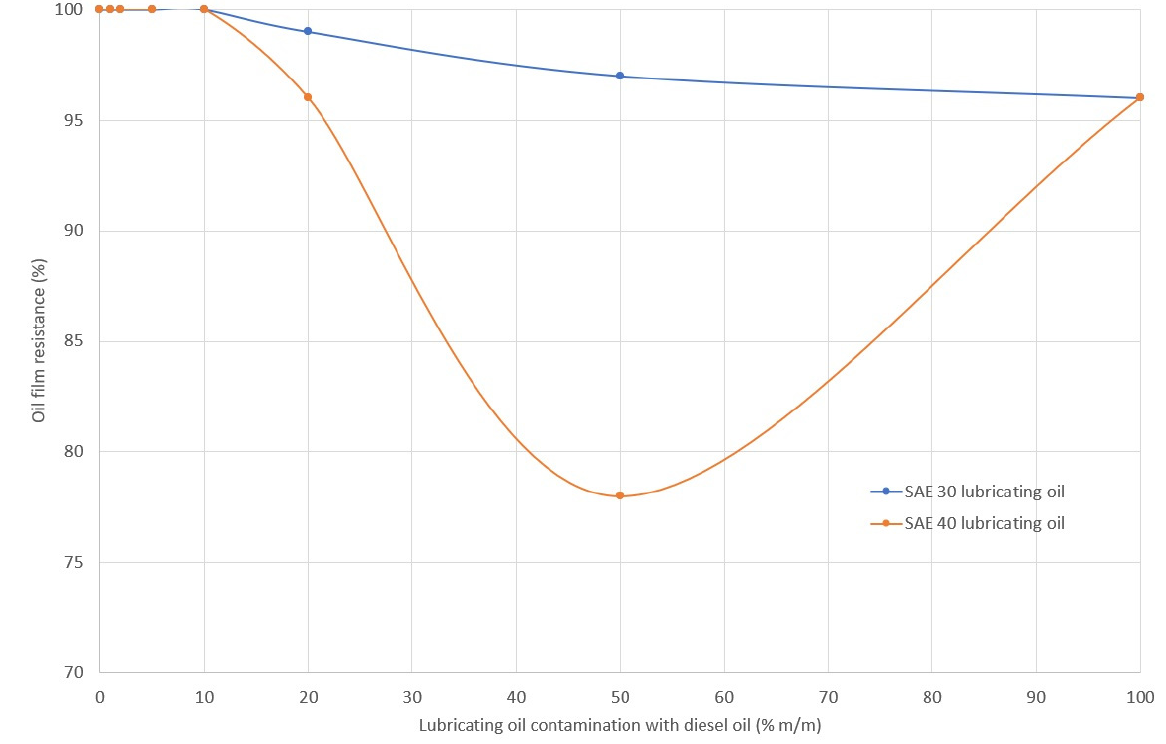
Figure 20. Percentage loss of oil film resistance of the lubricating oils tested at different levels of lubricating oil dilution with diesel fuel.